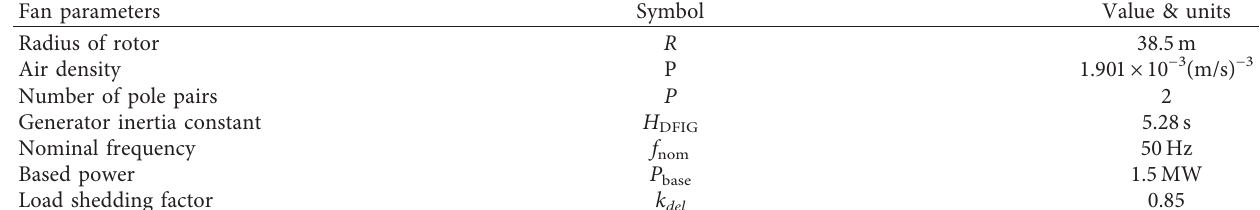
Table 2: Parameters of wind turbine.